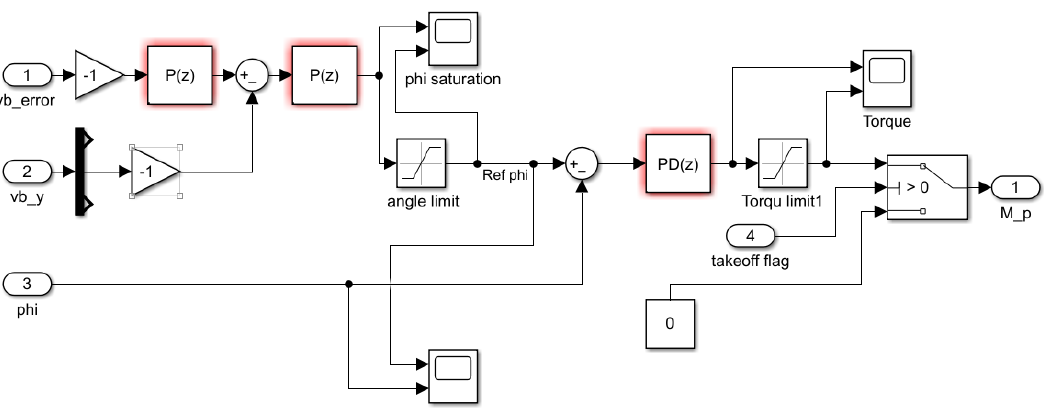
Figure 9. The PID controller controls Y ( Φ ).